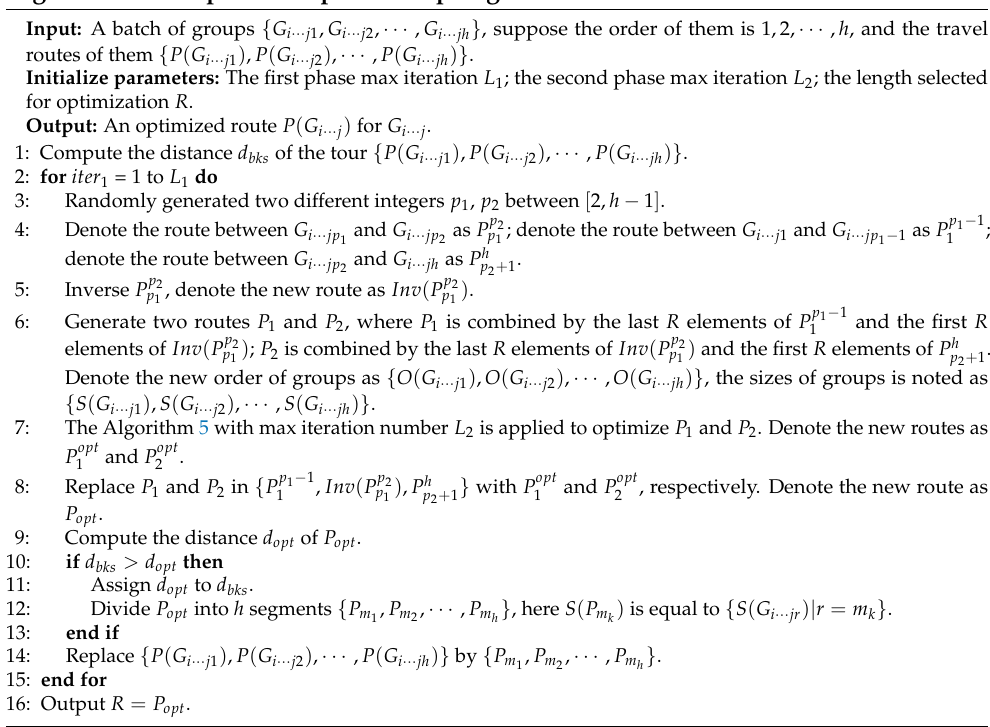
Algorithm 7 Two-phase simplified 2 -opt algorithm.